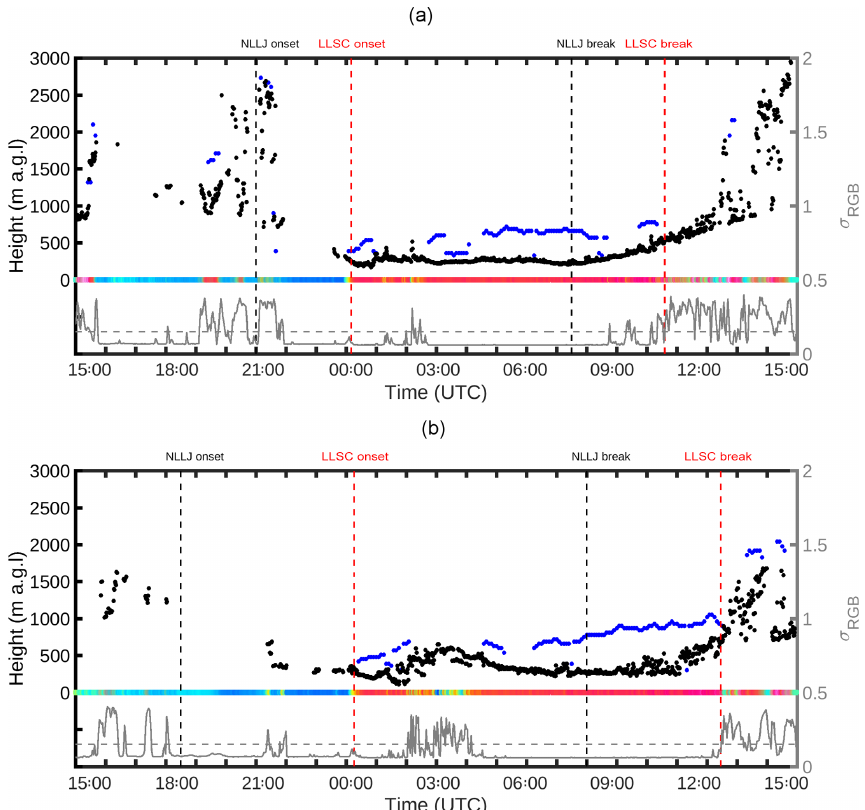
Figure 9. Time series of the LLSC macrophysical characteristics observed on the nights of (a) 7–8 July 2016 and (b) 6–7 July at Savè. The colored band indicates the time series of the average image obtained every 2min with the IR cloud camera. This time series is plotted arbitrarily at the 0m abscissa for the sake of clarity. The grey line indicates σ RGB (with its scale on the right axis) and the dashed grey line indicates for the threshold (0.15) above which the LLSC deck is not considered to be homogeneous. Black dots indicate the CBHs of the LLSCs estimated from the ceilometer. Blue dots indicate the CTHs of the LLSCs estimated from the cloud radar. The dashed black and red vertical lines indicate from left to right the NLLJ and LLSC onset and breakup